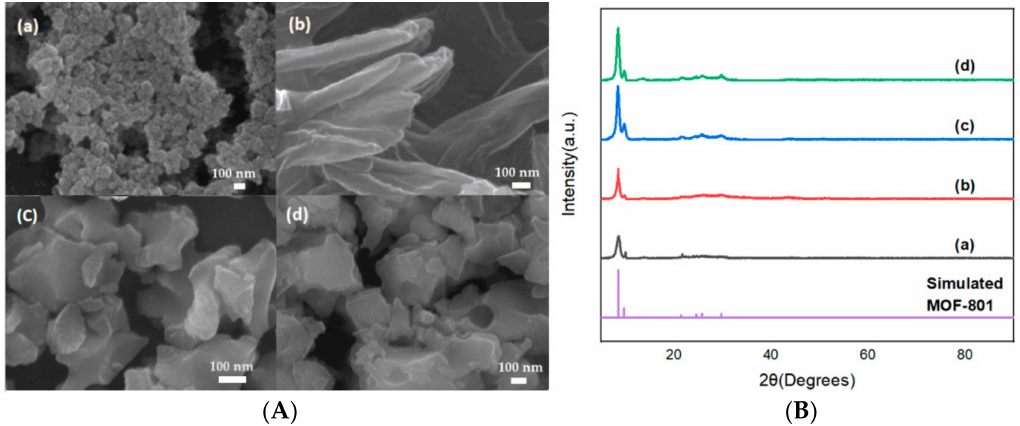
Figure 1. SEM ( A ) and XRD ( B ) diagrams of the samples prepared in ( a ) 20 mL of water, 20 mL of ethanol, with polyhedrons of approximately 100 nm; ( b ) 20 mL of water, 40 mL of ethanol, with rods; ( c ) 20 mL of water, 60 mL of ethanol, with polyhedrons of approximately 300 nm; ( d ) 20 mL of water, 80 mL of ethanol, with large polyhedrons of approximately 500